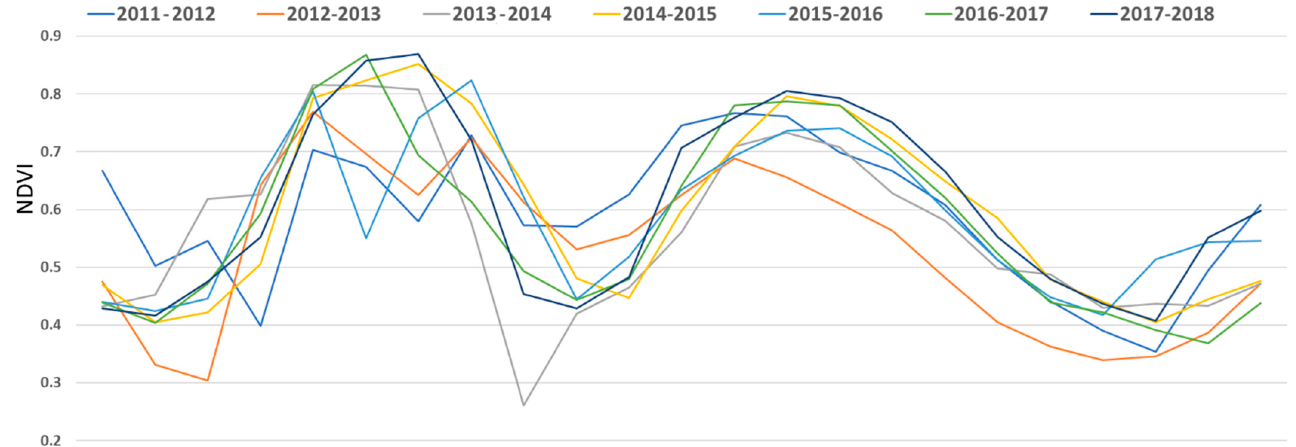
Figure 7. Inter-annual variability of the mean NDVI time series of the iCL class samples over Mato Grosso, for seven agricultural campaigns: 2012/2013, 2013/2014, 2014/15, 2015/16 (ENSO), 2016/17, 2017/18 and 2018/19